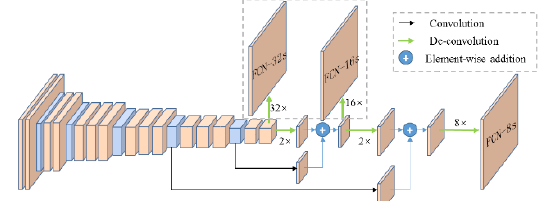
Figure 3. A simple example of the high-resolution networks.